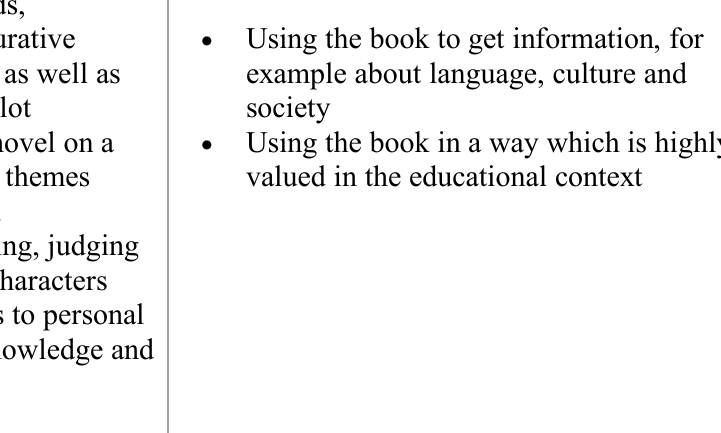
Table 1: Literacy practices (reworked from Luke & Freebody, 1999) Meaning-making